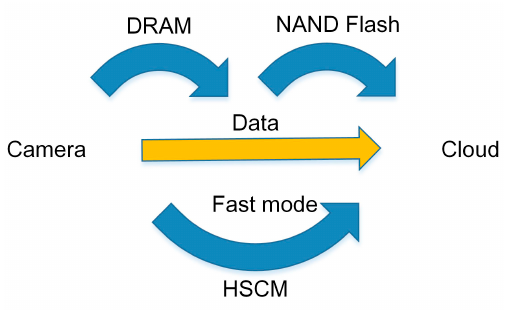
Figure 11. Video applications in IoT devices.